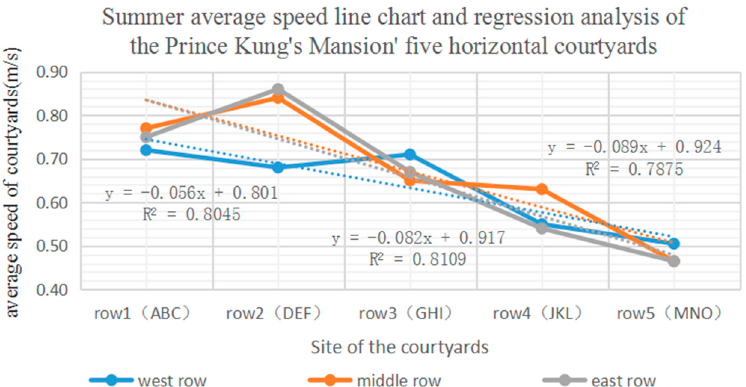
Figure 12. Average speed line chart and regression analysis of Prince Kung’s Mansion’ five horizontal courtyards in summer. The values of the figure was based on CFD simulation results.